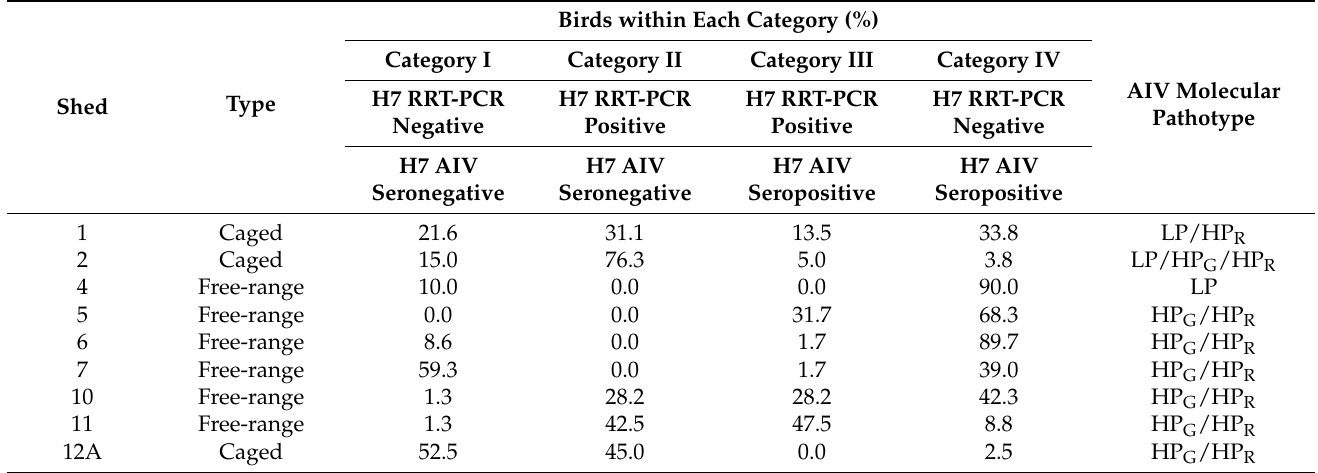
Table 7. Infection and antibody status of birds on the IP. The RRT-PCR and HI results from Sample Sets 2 and 3 were combined to determine the infection and antibody status of the birds and placed them into one of the four categories. Only birds from which RRT-PCR values and HI titers were determined were